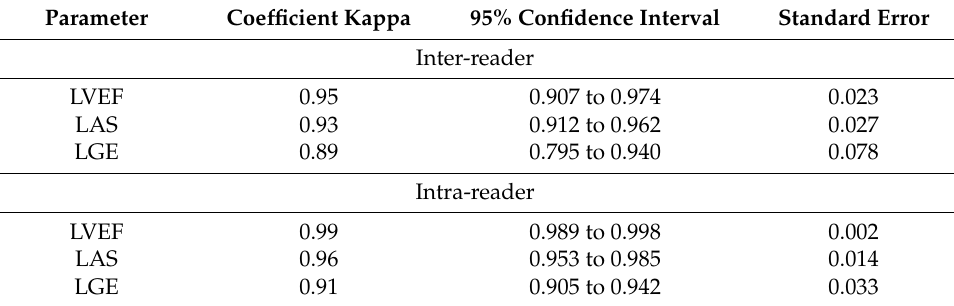
Table 2. Reproducibility inter and intra-reader agreement of CMR measurements.